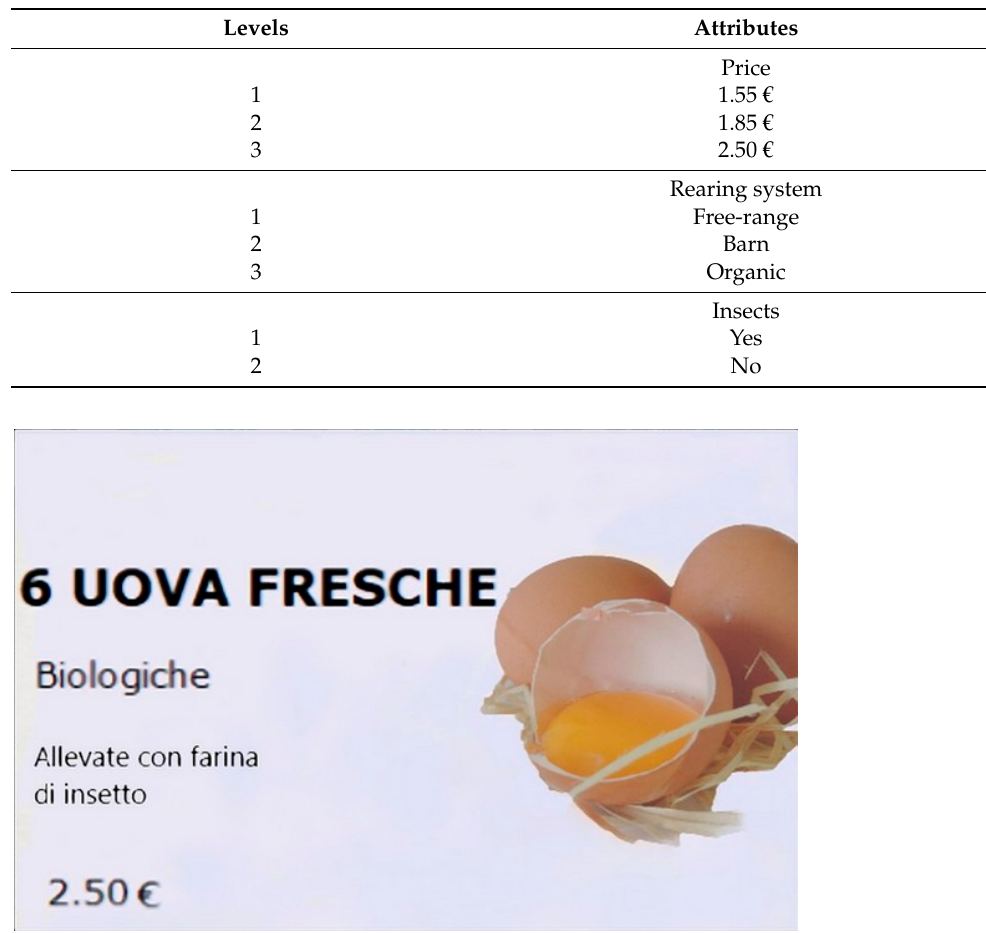
Table 1. Attributes and levels presented in the survey.